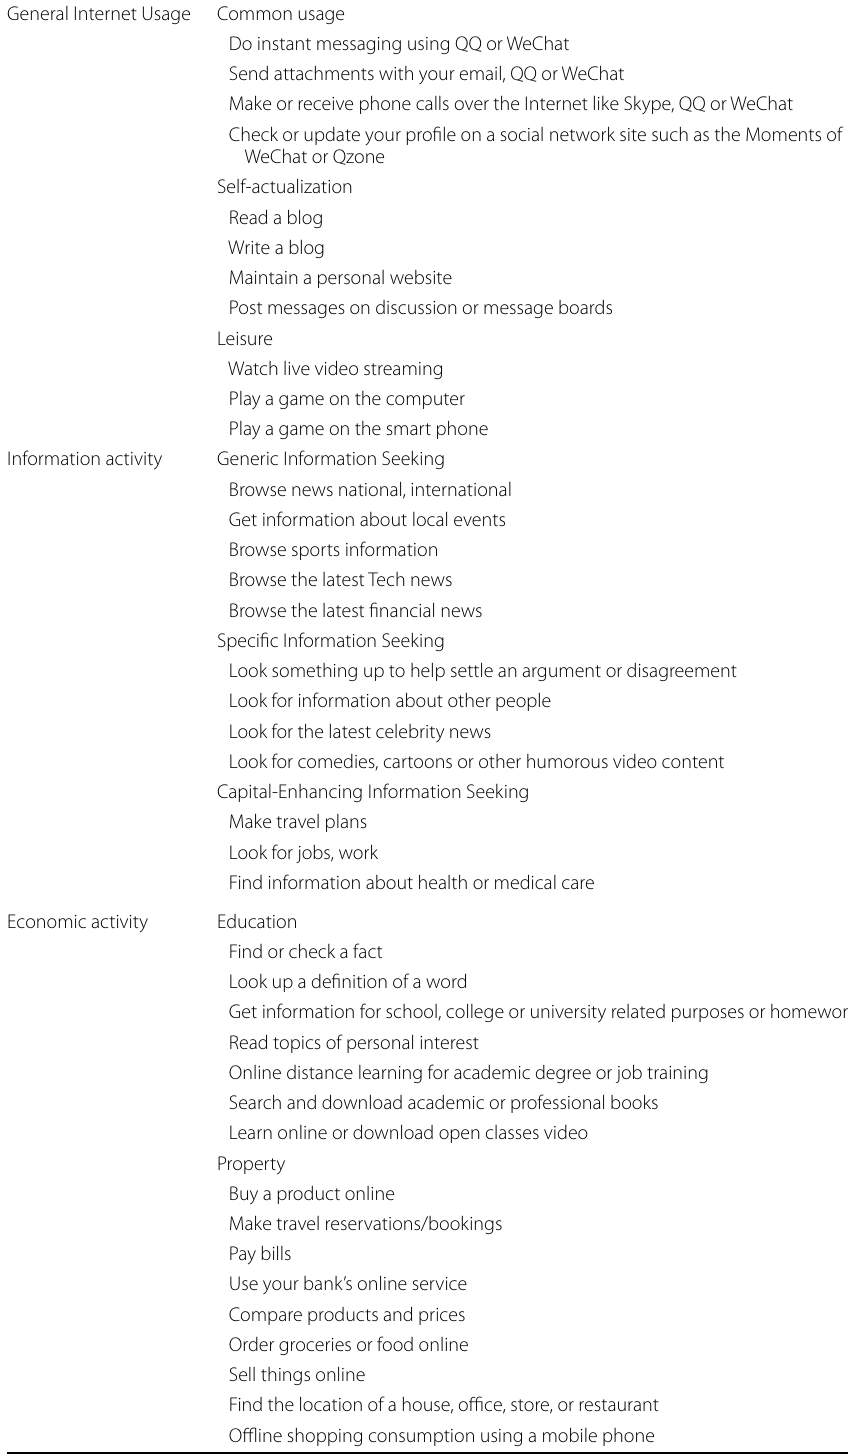
Table 5 Items used to evaluate types of Internet usage activities General Internet